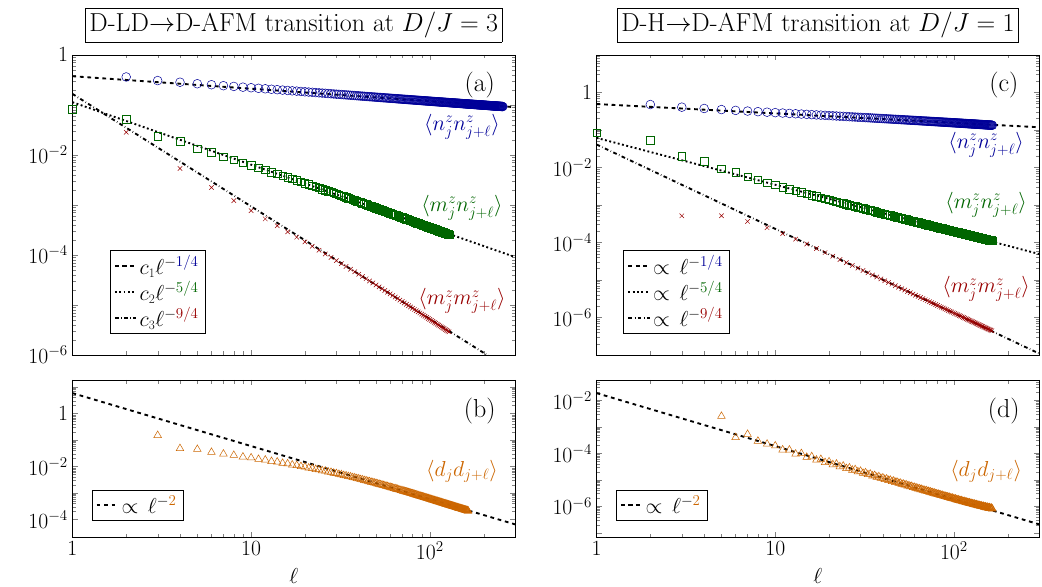
Figure 2: The connected longitudinal spin-spin (upper panels) and dimerization (lower panels) two-point functions at the Ising transition point for fixed D / J = 3 (left panels) and D / J = 1 (right panels) with δ = 0.1, obtained by iDMRG with χ = 1600. Correlation functions (symbols) show a power-law decay in accordance with the field-theory predictions Eqs. (29)–(32) [ lines ]